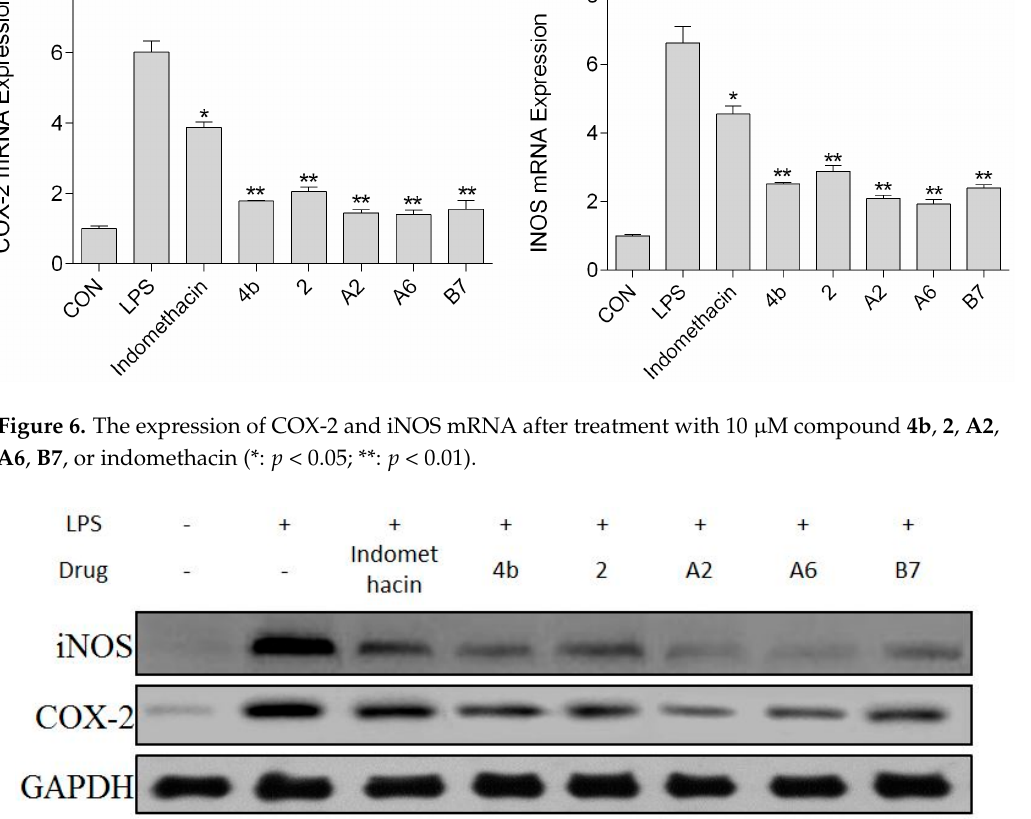
Figure 7. Immunoblotting of cellular proteins COX-2 and iNOS expression in RAW264.7 cells treated with 10 μ M compounds 4b , 2 , A2 , A6 , B7 , or indomethacin. GAPDH was used as a loading control.